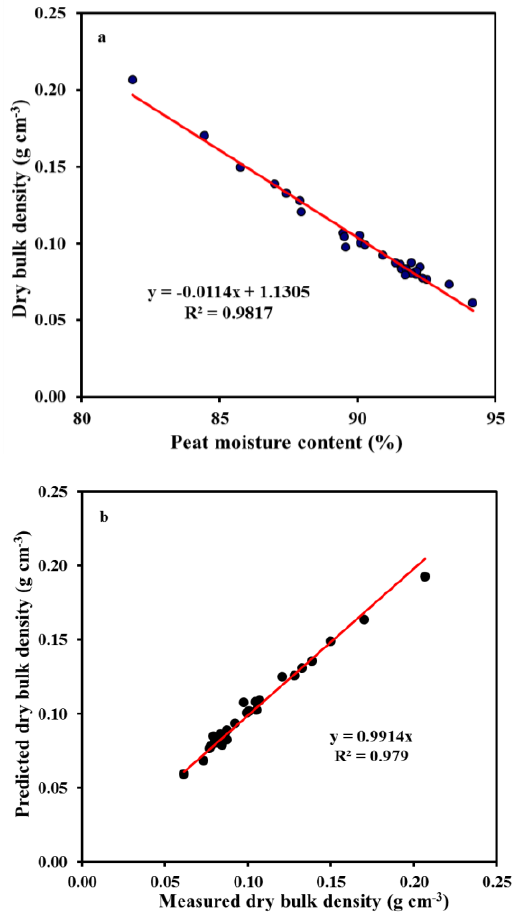
Figure 4. Regression of measured dry bulk density on gravimetric moisture content (a) and of predicted dry bulk density on measured dry bulk density (b) for a set of Scottish basin peats (Middlemuir and Red